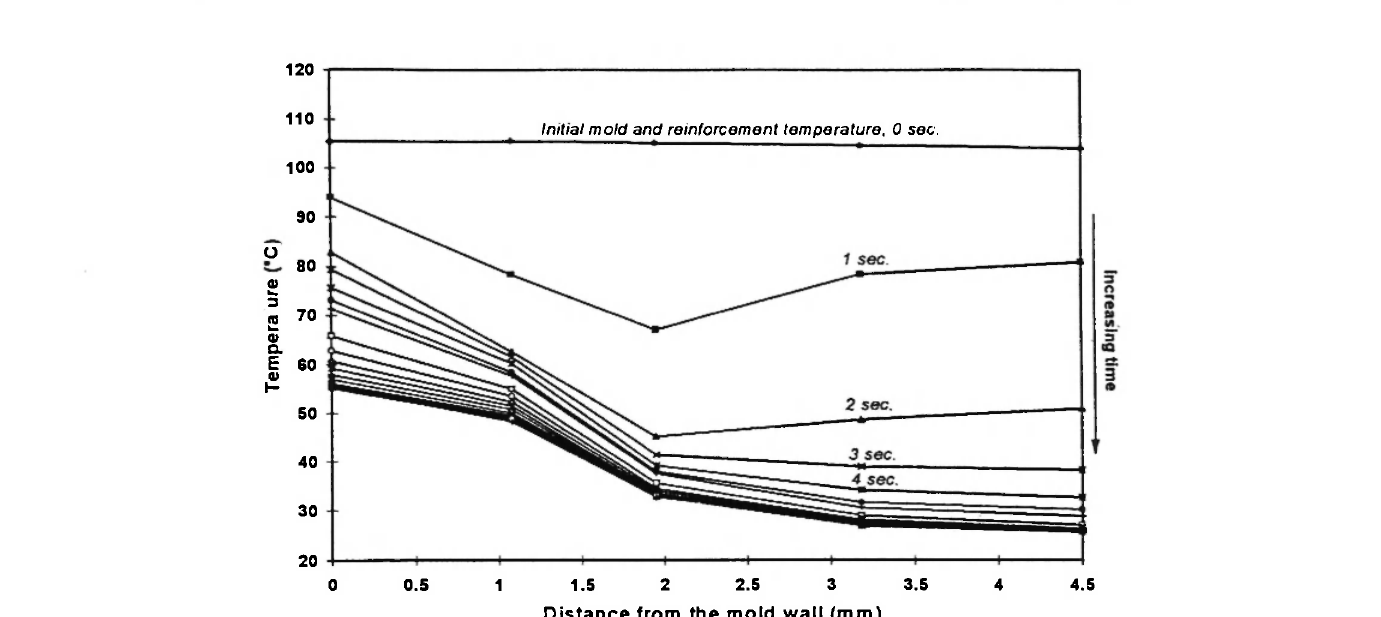
20 0 O.S Distance from the mold wall (mm) Evolution in time of through-thickness temperature in a typical RTM mold (from Lebrun Fig. 6: